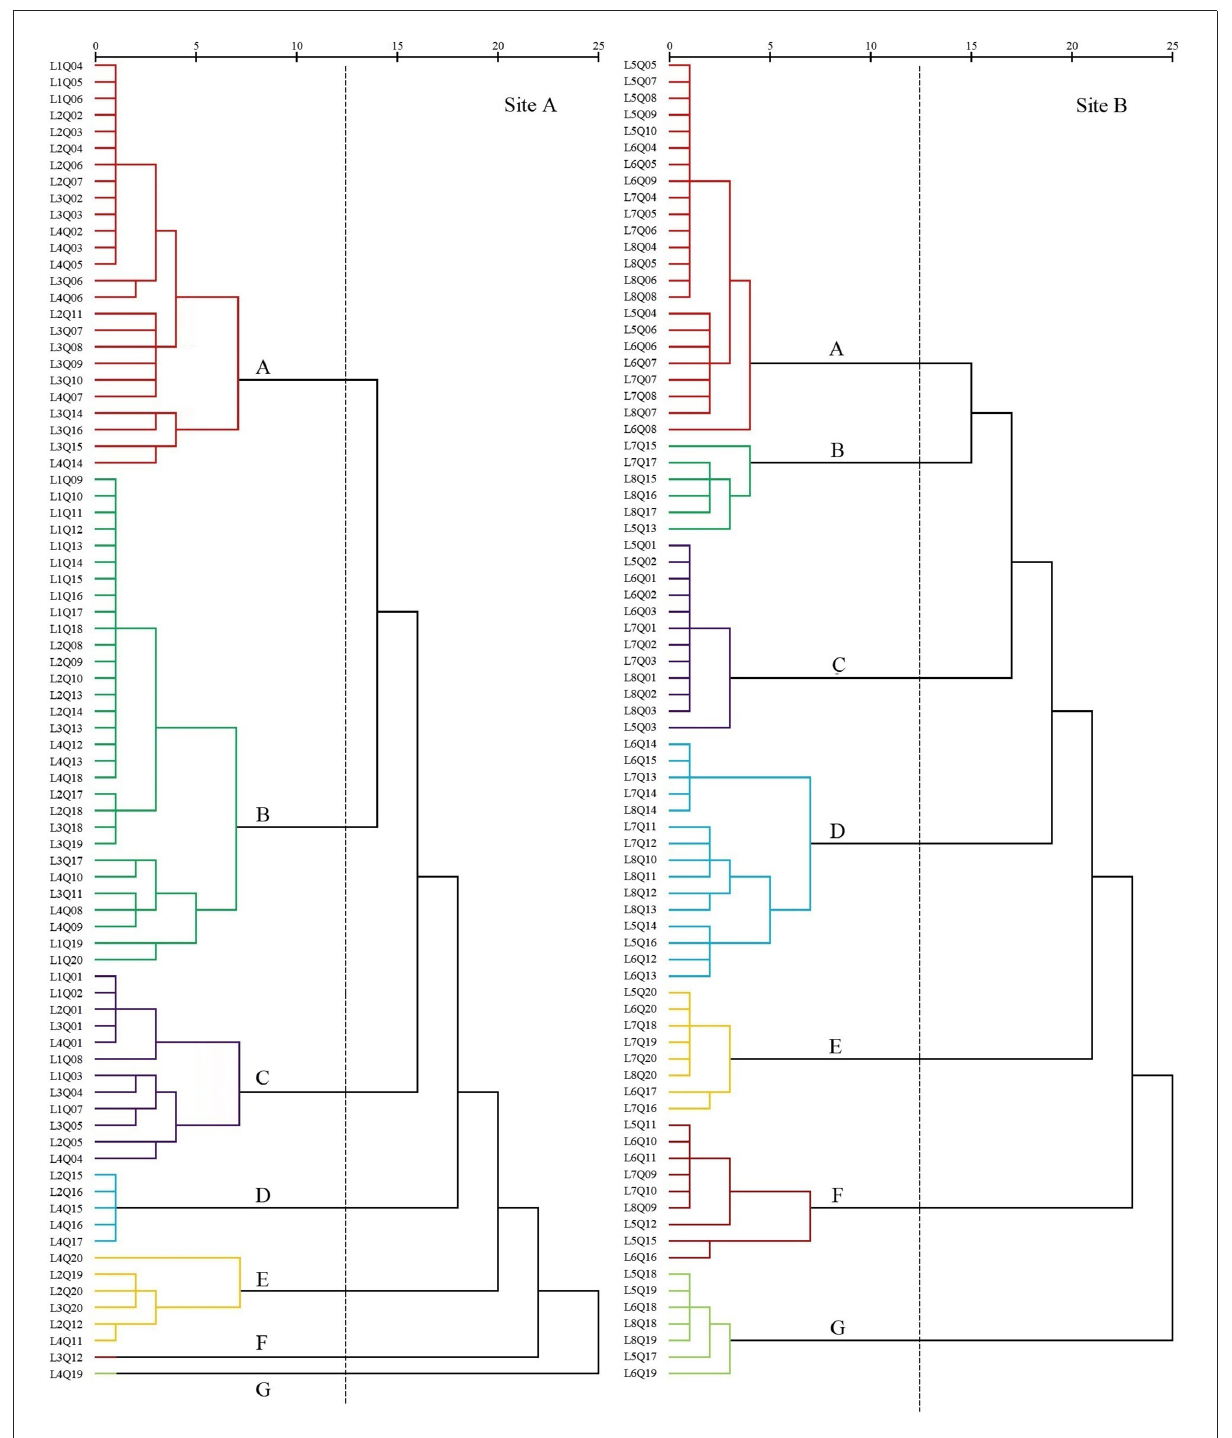
FIGURE3 Dendrogram of coastal wetland vegetation based on cluster analysis of data collected in 2008.